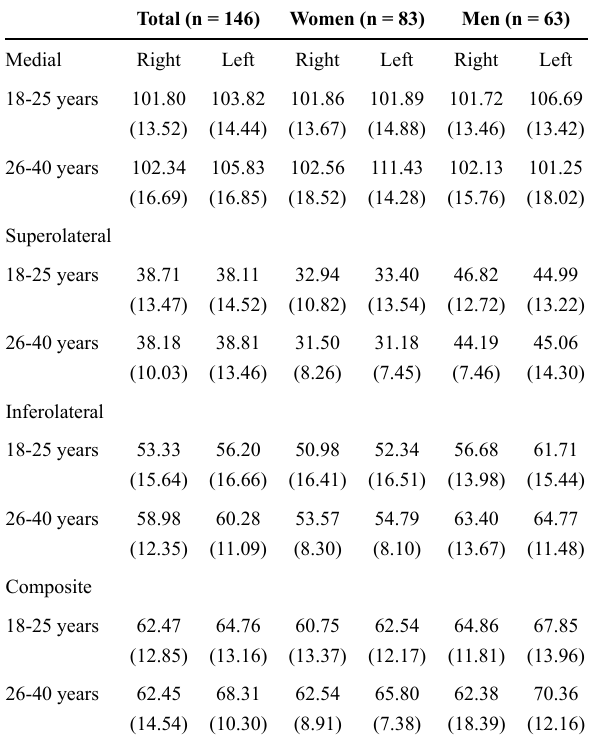
Table 3 - Mean and standard deviation for the Upper Quarter Y Balance Test scores according to gender and age category (n = 146).